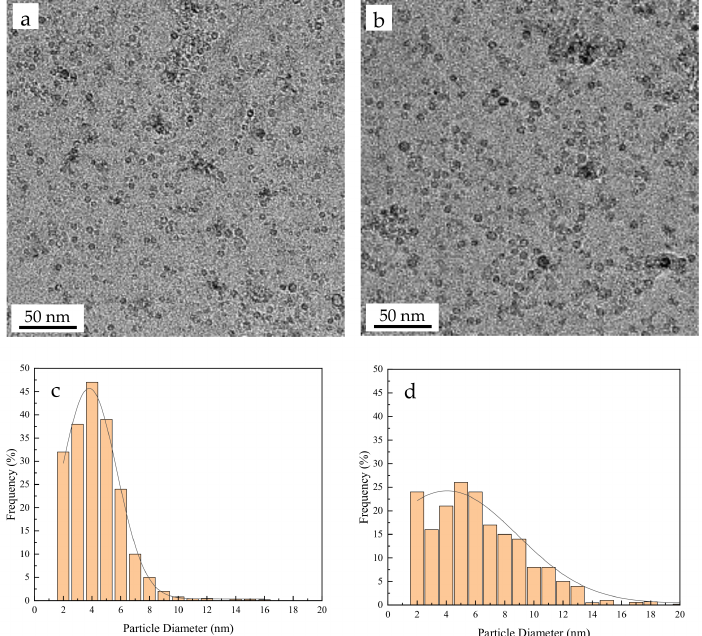
Figure 6. TEM views of nano-oxide particles and their size distributions in Fe-Cr-Al ODS alloys: before ( a , c ) high-temperature and after( b , d ) high-temperature